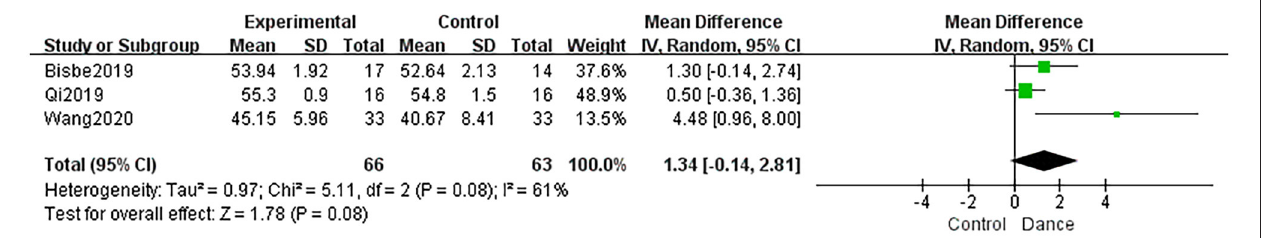
FIGURE 11 | Forest plot of balance results of dance group vs. control